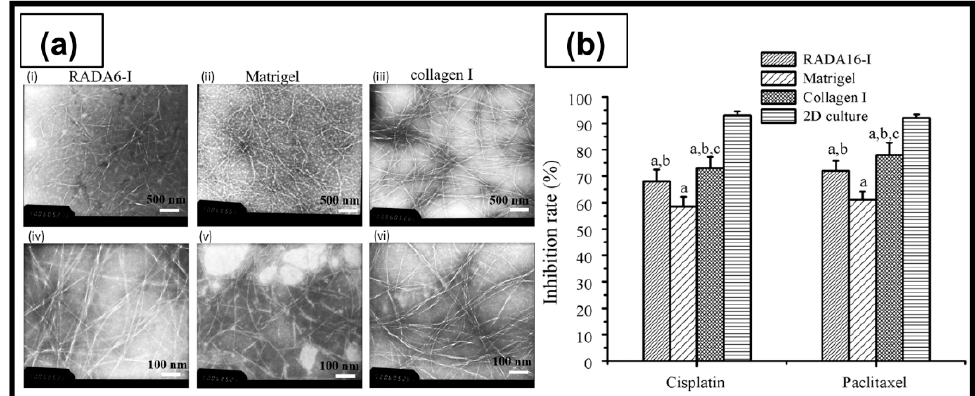
Figure 15. RADA16-I hydrogel. ( a ) Negatively stained TEM images showing the nanofiber morphology of RADA16-I (i,iv), Matrigel (ii,v), and collagen I (iii,vi) (scale bar, top panels (i–iii): ×8000; bottom panels (iv–vi): ×15,000). ( b ) Cisplatin and paclitaxel responses of chemosensitivity assay in HO-8910PM cells cultured in gel-cell clumps and common 2D flat cell plates: a ( p < 0.01) compared with that of 2D cell culture model; b ( p < 0.01) compared with that of Matrigel; c ( p < 0.01) compared with that of RADA16-I hydrogel [206] .